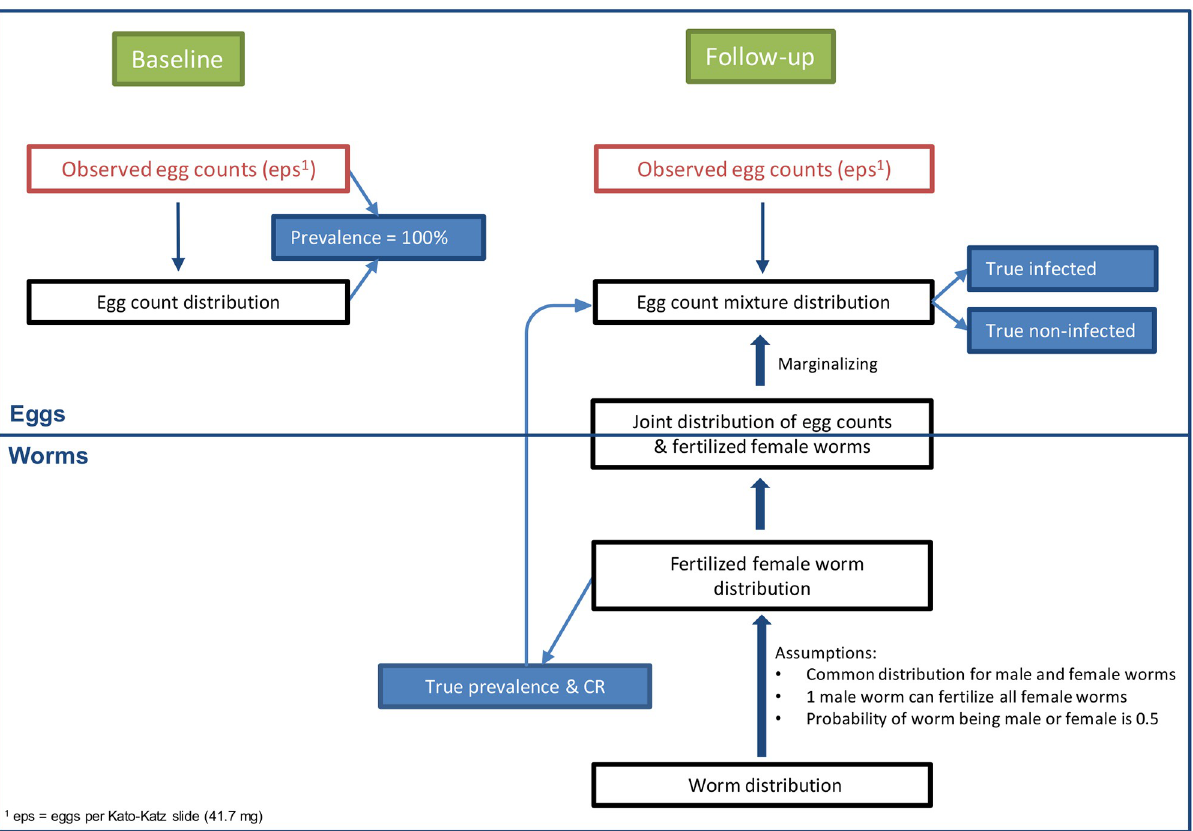
Fig 1. Graphical representation of the model. Numbers in brackets indicate equation numbers as given in the text below and in S2 Appendix.